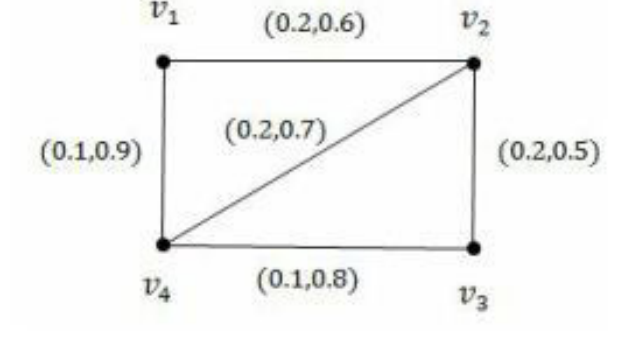
Figure 16. VG ( G 4 ).